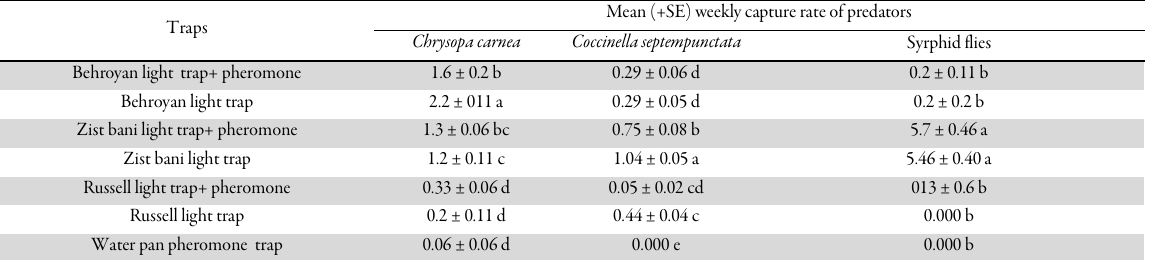
Table 3. Mean weekly captured of Chrysopa carnea, Coccinella septempunctata and Syrphid flies (Mean ±SE) in experimental traps during whole growing season of tomato